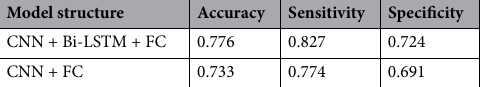
Table 2. Comparison of model